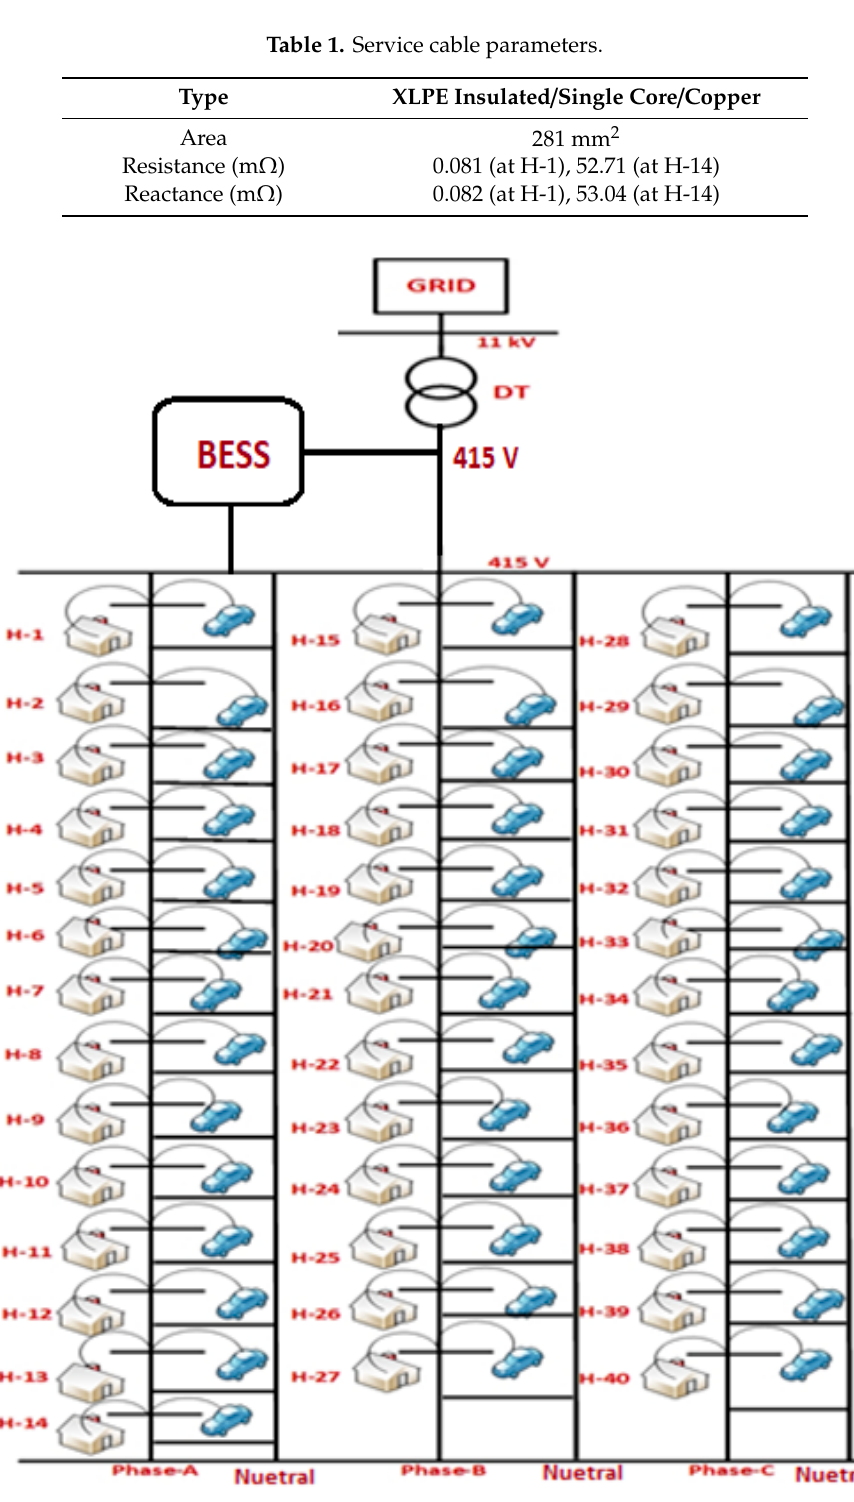
Figure 2. Single line diagram of the modeled 40-house network.